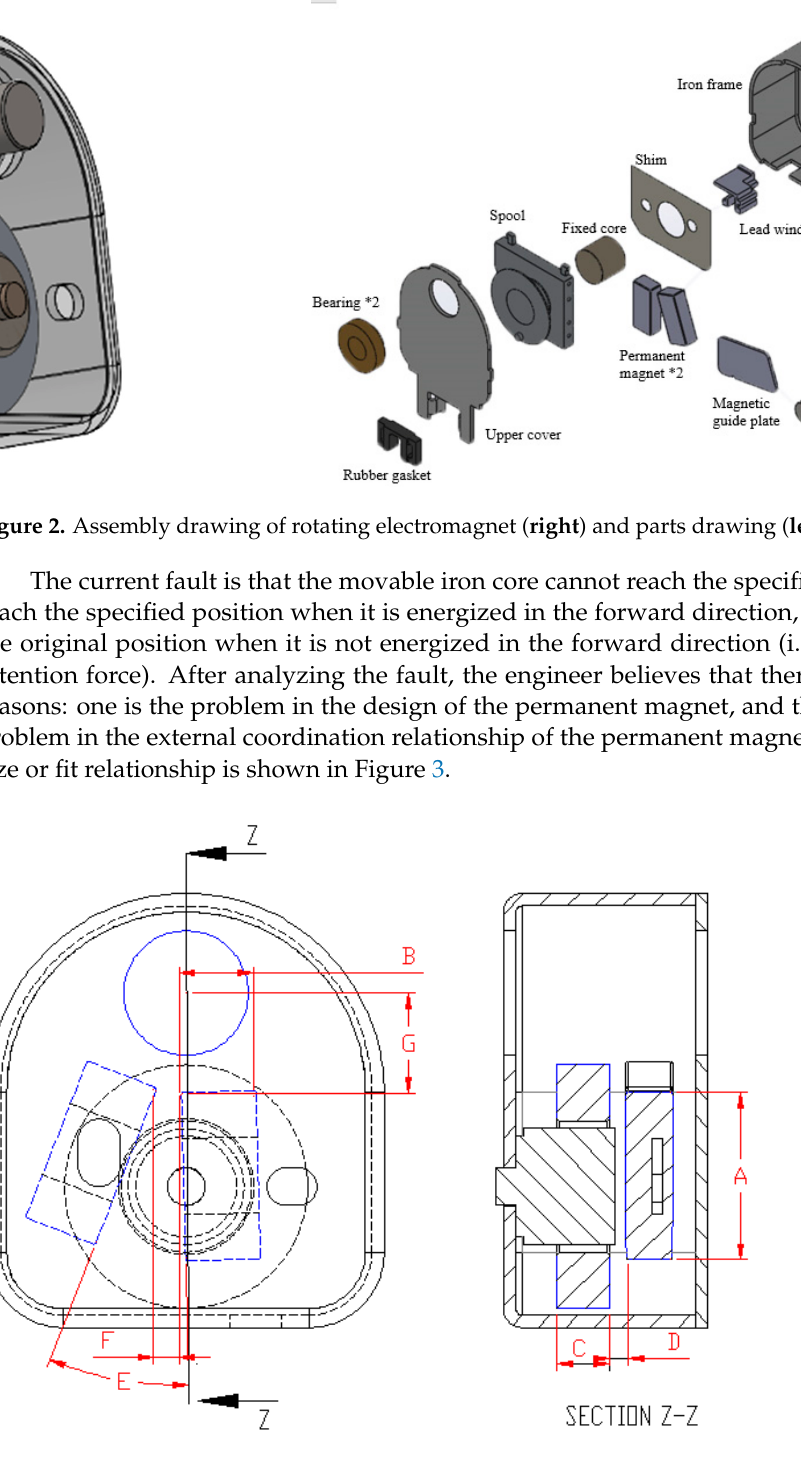
Figure 3. Permanent magnet size and external matching relationship. A—length of permanent magnet, B—width of permanent magnet, C—thickness of permanent magnet, D—distance between permanent magnet and coil, E—included angle between permanent magnets, F—distance between permanent magnets, G—distance between permanent magnet and guide rod. The flow chart of the electromagnet manufacturing process fault analysis, based on the fuzzy fault tree and D–S evidence theory, is shown in Figure 4.